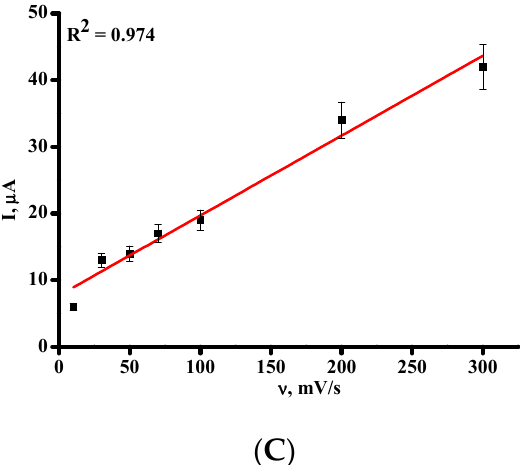
Figure 2. ( A ) CV of dsDNA (1.5 mg/mL) on SPE/SWCNT in the range of potentials of 0 V to 1.2 V at scan rates from 10 to 300 mV/s. Dependence between guanine ( B ) and adenine ( C ) peak currents and the scan rate.